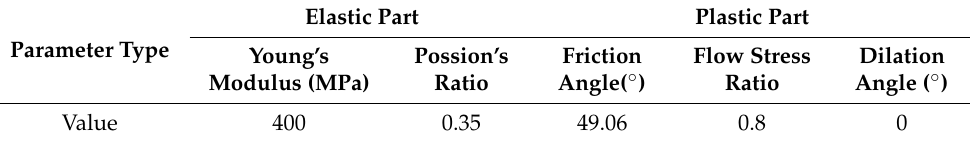
Table 3. Parameters of Druck-Prager